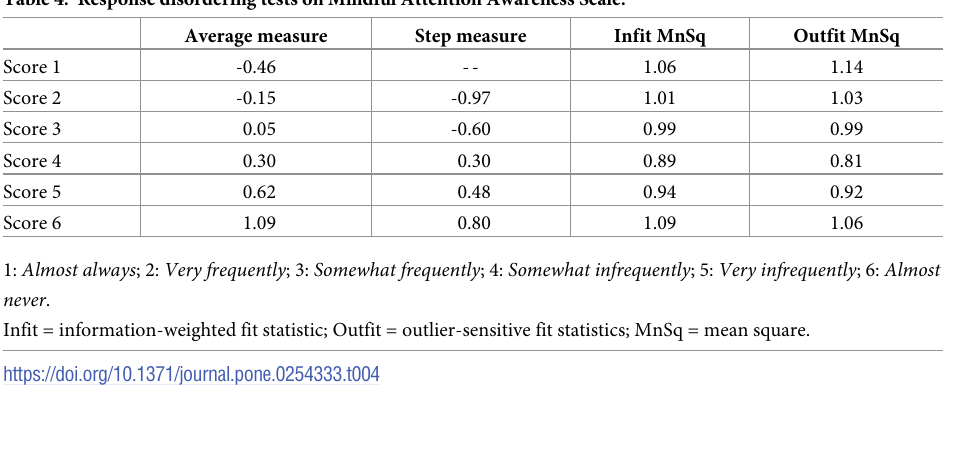
Table 4. Response disordering tests on Mindful Attention Awareness